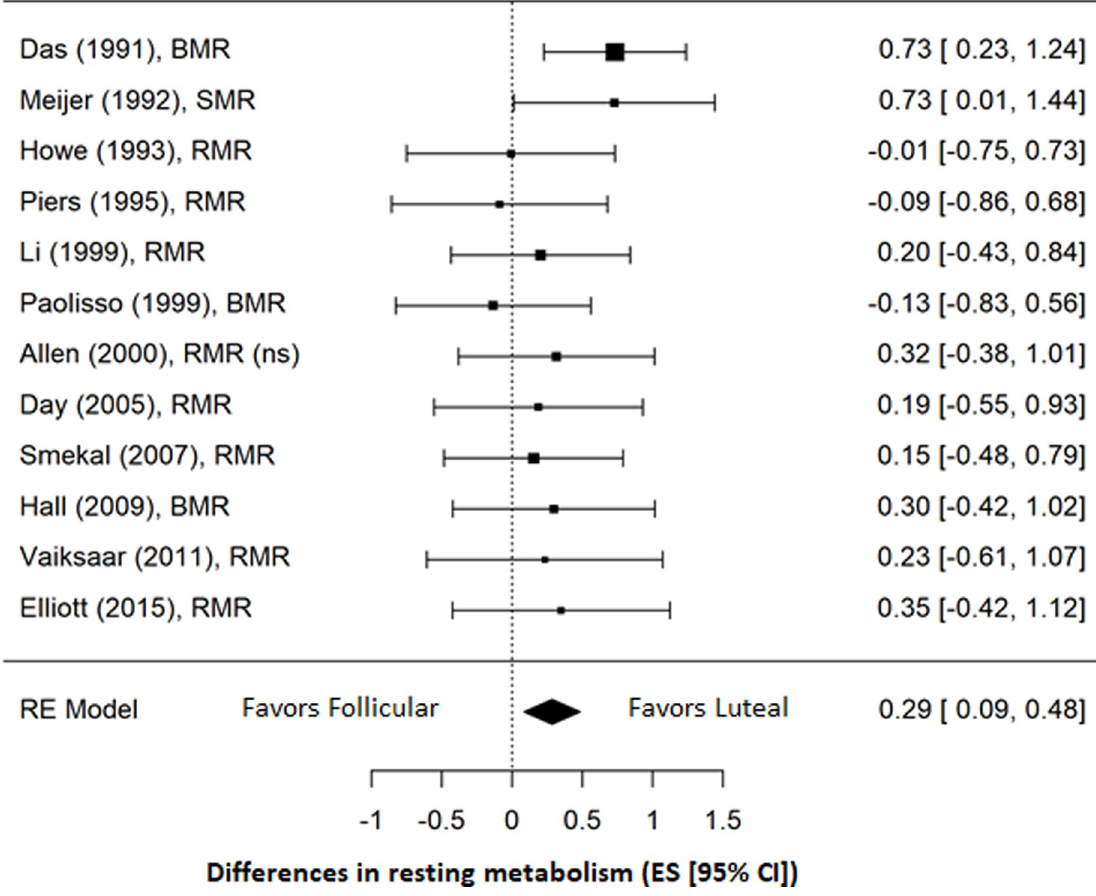
Fig 5. Forrest plot of sub-group analysis of studies with samples of more than 10 participants. (ns) = non-smokers.